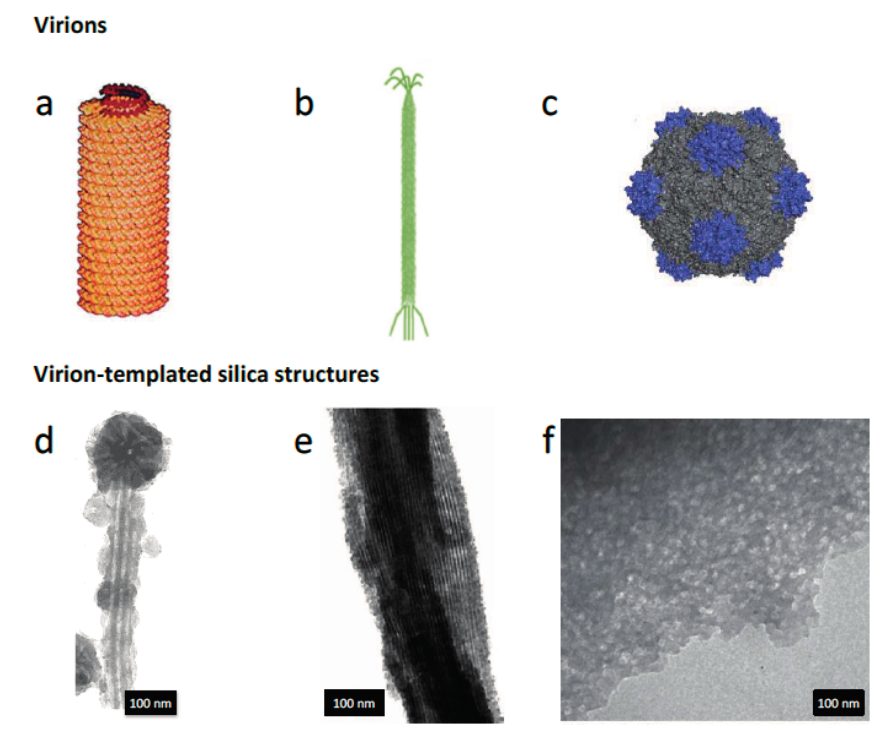
Figure 5. Macromolecular structures of different virus used for silica templating: ( a ) Tobacco mosaic virus; ( b ) T4 bacteriophage; and ( c ) Cowpea mosaic virus. TEM photos shown in ( d – f ) display the silica morphology obtained after calcination of TMV-, T4 bacteriophage- and CPMV-silica hybrids, respectively. ( a , c , f ) is reproduced with permission of Springer from reference [73]; ( b ) is reproduced from reference [74] with permission of The Royal Society of Chemistry; ( d ) and ( e ) are reproduced from references [71] and [72], respectively, with permission from